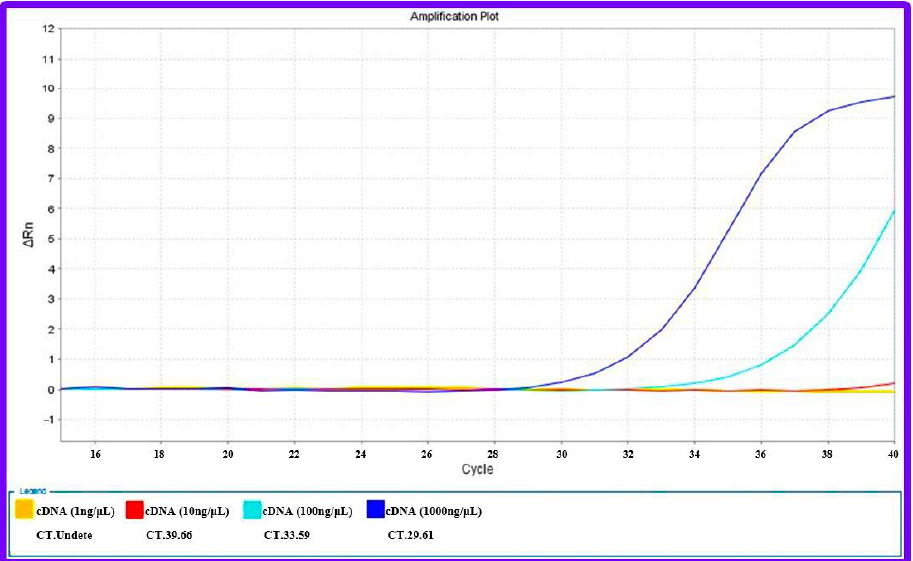
Figure 10. qRT-PCR results for different concentrations of RNA sample extracted from AGS cell